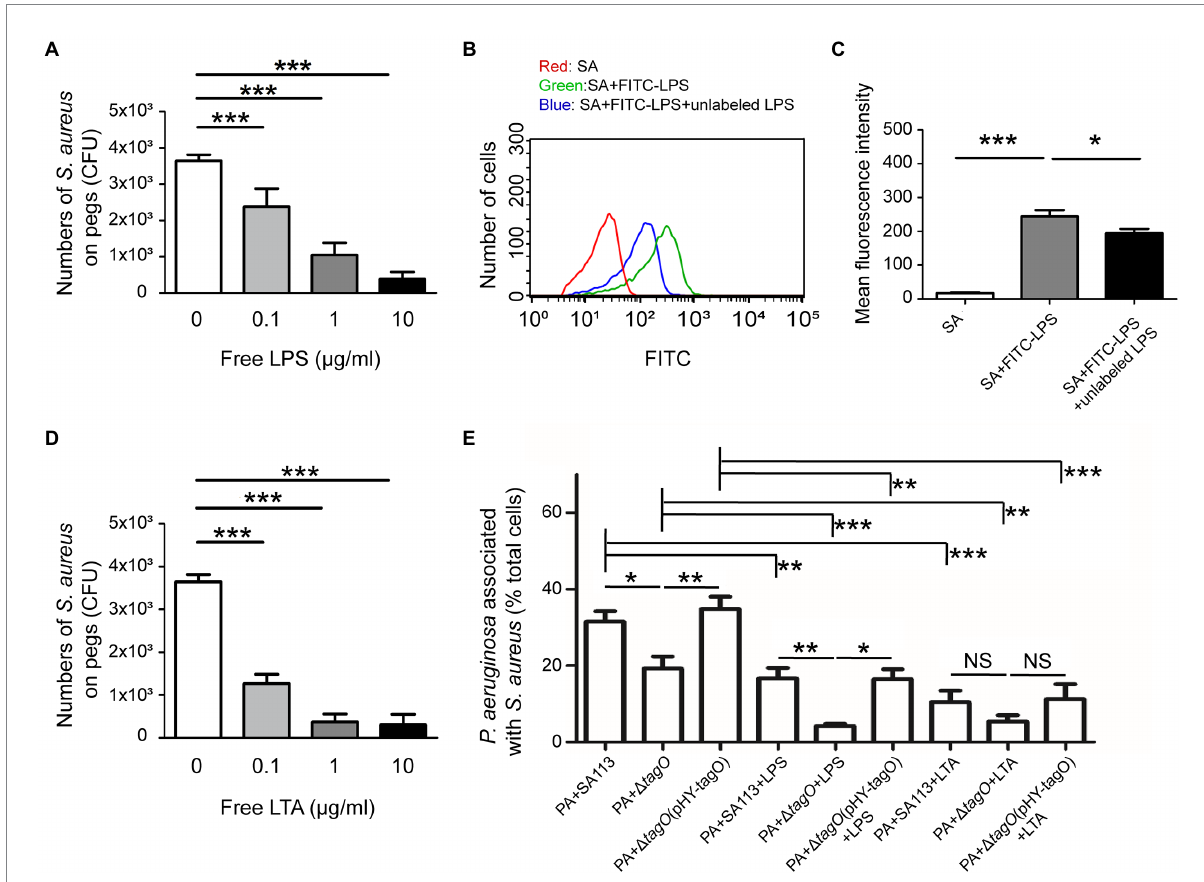
FIGURE 3 Interaction between WTA of Staphylococcus aureus and LPS of Pseudomonas aeruginosa. Staphylococcus aureus SA113 was mixed with various concentrations of free LPS (A) or LTA (D) for 10 min, and then mixed with P. aeruginosa PAO1. The mixtures were seeded into the wells of CBD plates. The number of S. aureus on pegs was determined. (B) Staphylococcus aureus SA113 (SA) was incubated alone (red) or with FITC-LPS in the absence (green) or presence (blue) of unlabeled LPS. The binding of FITC-LPS to S. aureus SA113 was analyzed by flow cytometry. The representative histogram of flow cytometry was shown. (C) Mean of fluorescence intensity of FITC-LPS bound S. aureus was measured and analyzed using Guavasoft 3.3. (E) Pseudomonas aeruginosa and S. aureus strains were labeled with SYTO 9 and hexidium iodide, respectively. Pseudomonas aeruginosa was incubated with S. aureus in the absence or presence of free LPS or LTA. After incubation, the cells were analyzed by flow cytometry. The data shown are the average percentage of P. aeruginosa associated with S. aureus in total analyzed P. aeruginosa . Bar presents as the mean of the results from more than three independent experiments and analyzed statistically using One-way ANOVA. Error bars indicate the standard deviations. Significant differences are denoted as follows: * indicates p < 0.05, ** indicates p < 0.01, and *** indicates p <